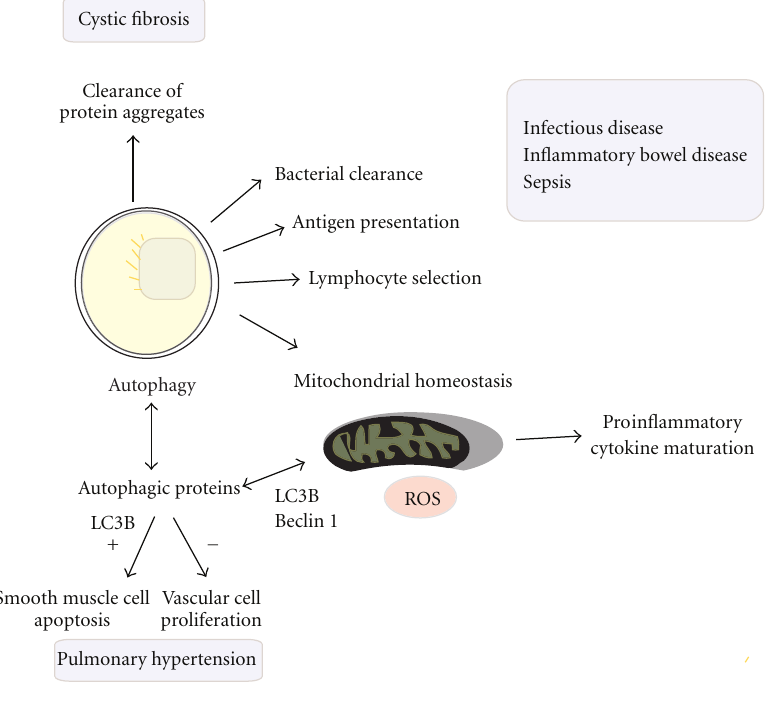
Figure 2: Autophagy as an adaptive cellular process potentially impacts the progression of inflammatory diseases by several possible mechanisms. (i) Autophagy, by acting as a “xenophagic” response, directly participates in bacterial clearance, through the encapsulation and lysosomal delivery of invading bacteria for degradation. (ii) Autophagic processes can assist in antigen presentation through the digestion of invading pathogens. (iii) Autophagic proteins play a role in the dampening proinflammatory responses, including proinflammatory cytokine secretion, through the maintenance of mitochondrial quality. (iv) Autophagic degradation of denatured protein aggregates may play a protective role in tissues such that impaired function has been associated with diseases such as cystic fibrosis [5]. (v) Autophagic protein LC3B potentially regulates other cellular processes as recently described in a model of hypoxia-induced pulmonary hypertension. In these studies, LC3B was found to inhibit vascular cell proliferation and promote smooth muscle cell apoptosis, collectively associated with protection in this model